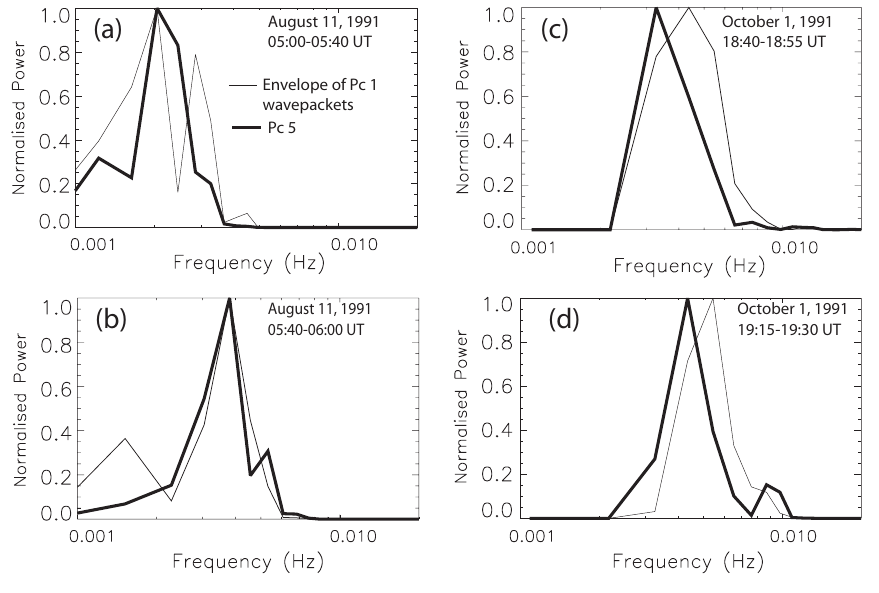
Fig. 5. Normalised power spectra for 11 August 1991 and 1 October 1991 time intervals. Thinlines represent spectra of Pc 1 transverse wavepacket envelopes, while thicklines are the spectra of Pc 5